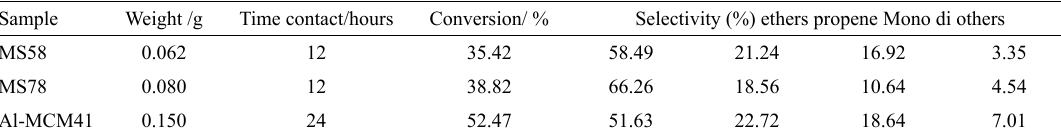
Table 2. Results of the products from the dehydration reaction of 1-propanol in the presence of mesoporous catalytic supports functionalized with sulfonic groups. 10mL of 1-propanol; reflux temperature: 371K